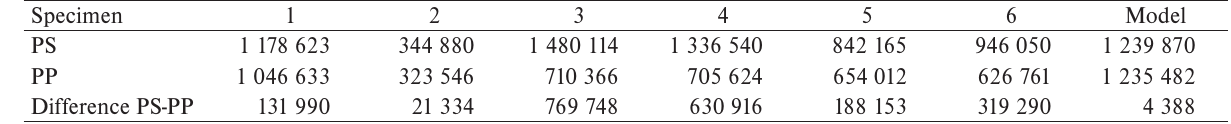
Table 1. Bending stiffness values [MPa∙mm 4 ] for loading a.